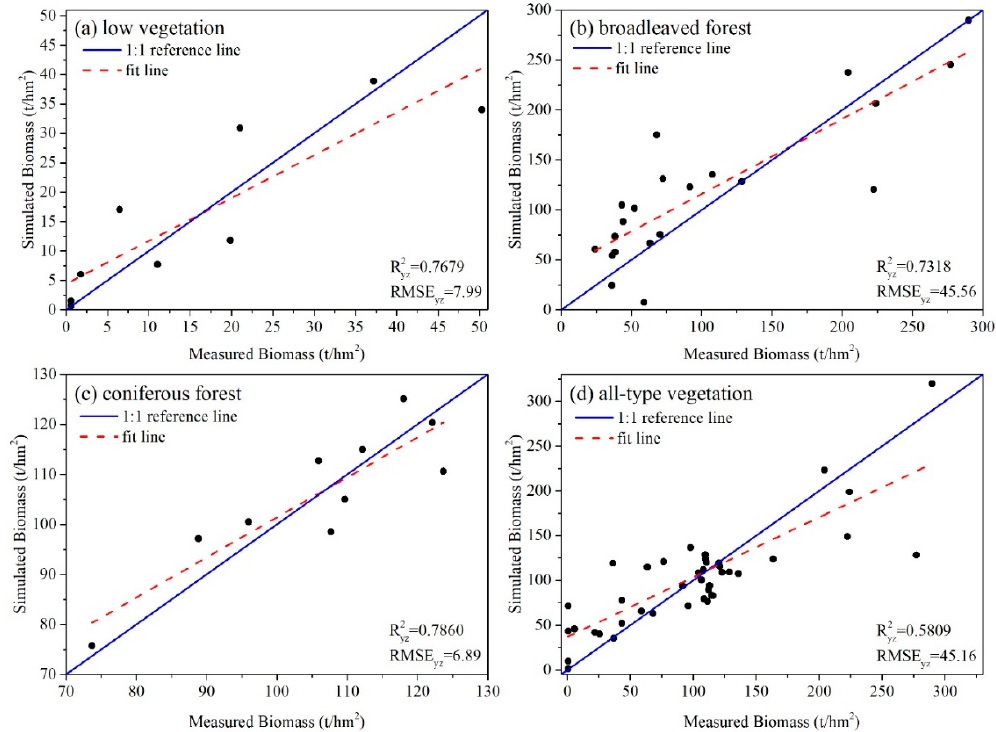
Figure 5. Accuracy assessment of the SR biomass estimation models: ( a ) low vegetation; ( b ) broadleaved forest; ( c ) coniferous forest; and ( d ) all-type vegetation.